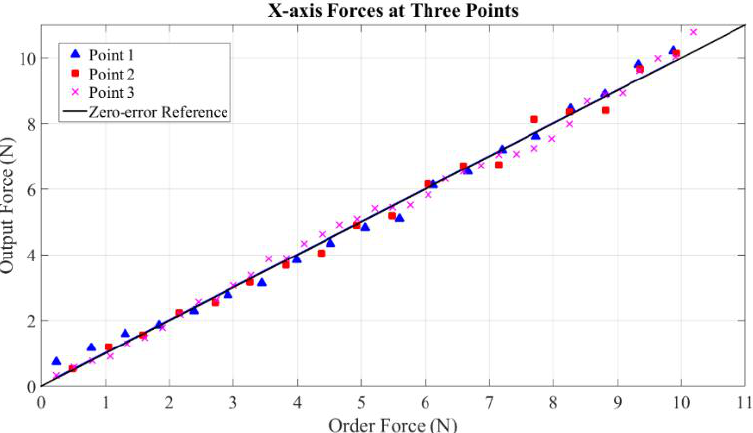
Figure 18. Forces at three points along X-axis.